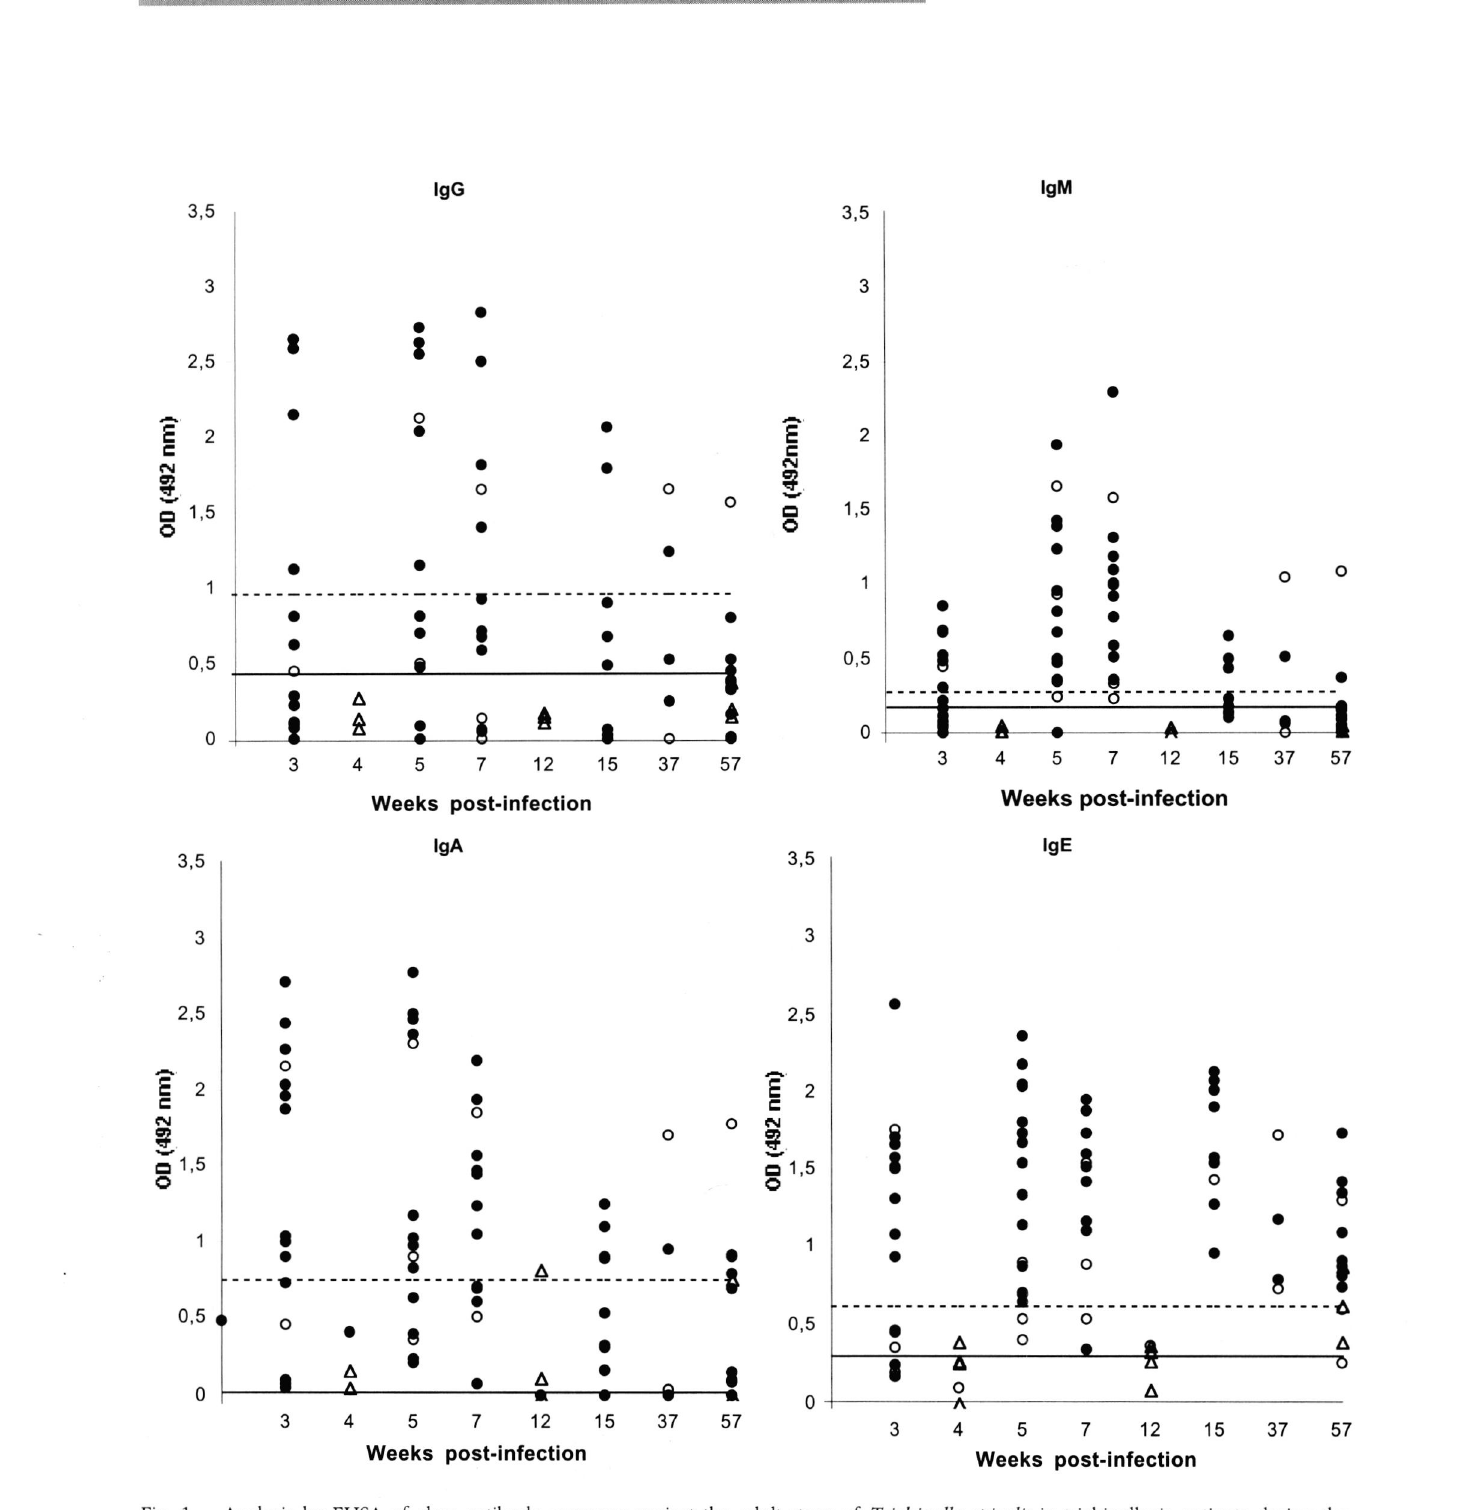
Fig. 1. - Analysis by ELISA of class antibody response against the adult stage of Trichinella spiralis in trichinellosis patients during the infection. I-ELISA assays were carried out to detect IgM and IgG antibodies as described in material and methods. Serum samples from symptomatic trichinellosis patients with: • positive or O negative biopsy and from • asymptomatic individuals, were analyzed. Doted line: cut-off value (media + 3σ from patients with other parasitosis). Line: cut-off value from healthy individuals.